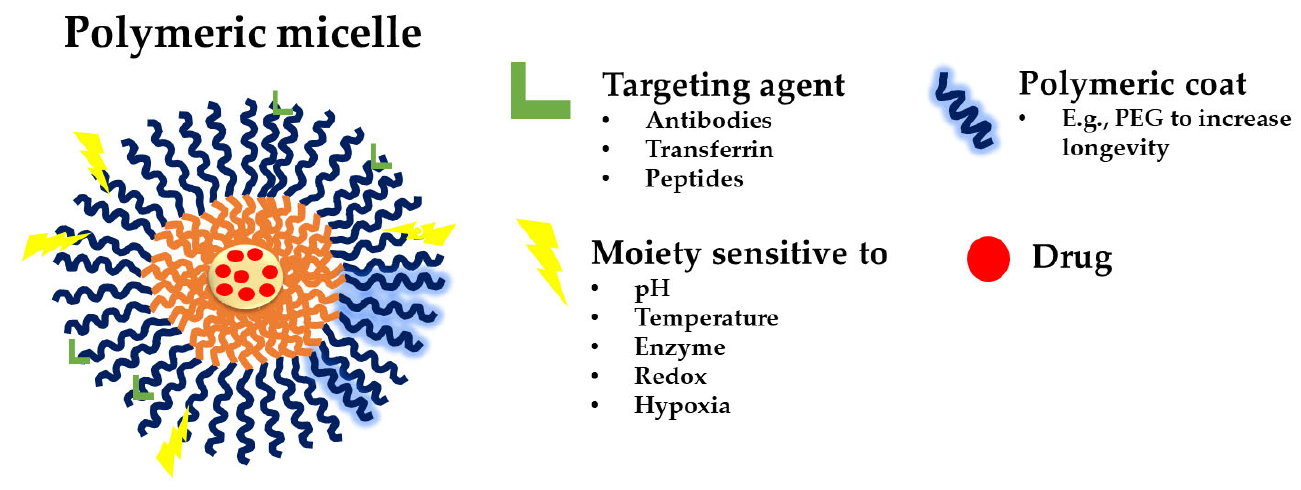
Figure 1. Schematic representation of a polymeric micelle functionalized with different moieties.